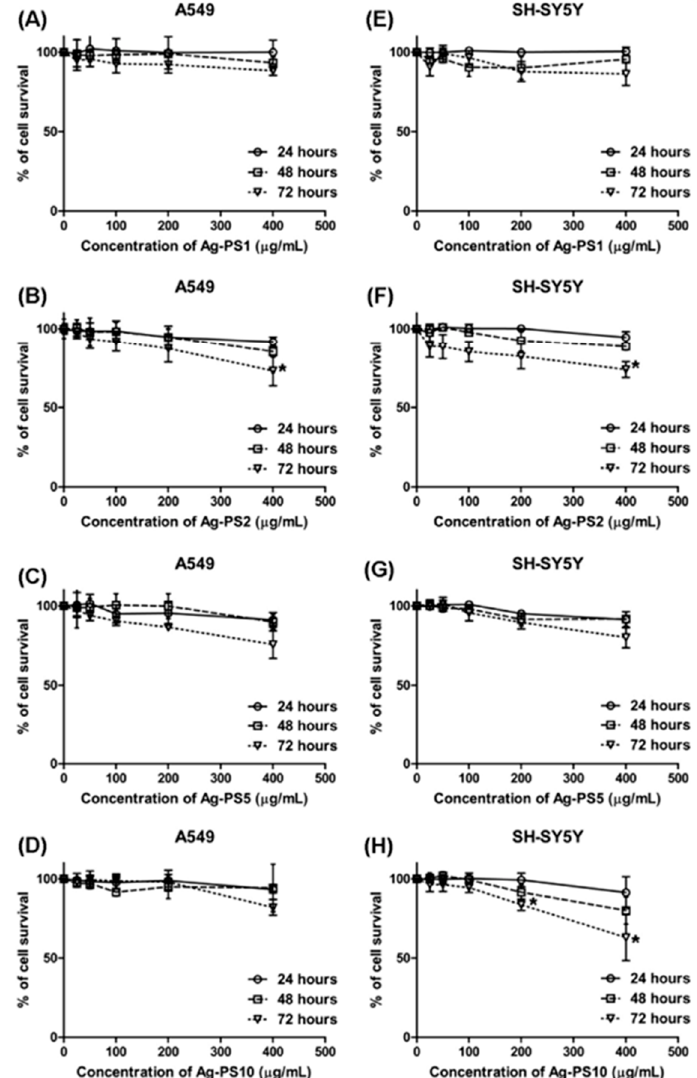
Figure 8. Viability study of MTT [3-(4,5-dimethylthiazolyl-2)2-5-diphenyltetrazolium bromide] assay on A549 ( A – D ) and SH-SY5Y ( E – H ) human cell lines exposed to various concentrations (0–400 µg/mL) of different Ag-PS NPs for 24, 48 and 72 h; * refers to the significantly different cytotoxic effect than that of the control. (Reproduced with the permission from Ref. [144]. Copyright © 2019 Elsevier B.V. All rights reserved.)